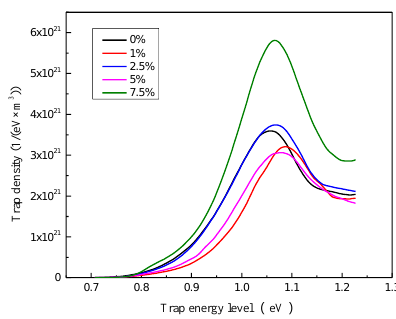
Figure 10. Trap density changing with trap energy level of nano-composite pressboards.